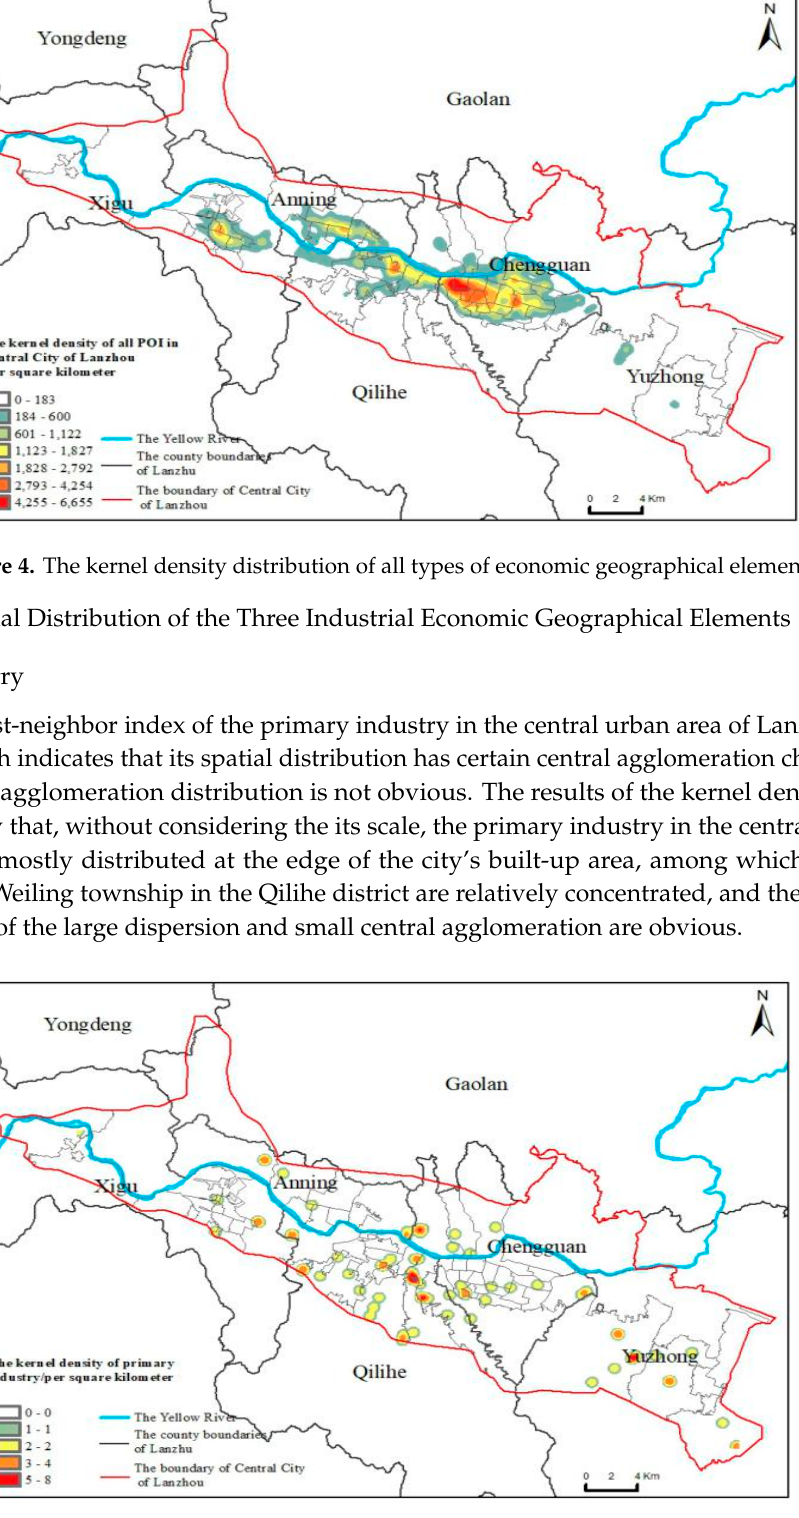
Figure 6. The kernel density distribution of secondary industry